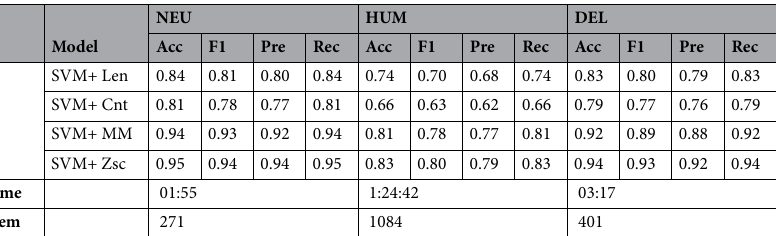
Table 7. A separate experiment demonstrates the efficacy of our approach if a gene does not have any MSRUs on Test-6 of all three datasets. Accuracy indicated by Acc, F1-score indicated by F1, Precision indicated by Pre, and Recall indicated by Rec. Also, the time is reported in the format hh:mm:ss while the peak memory usage is in